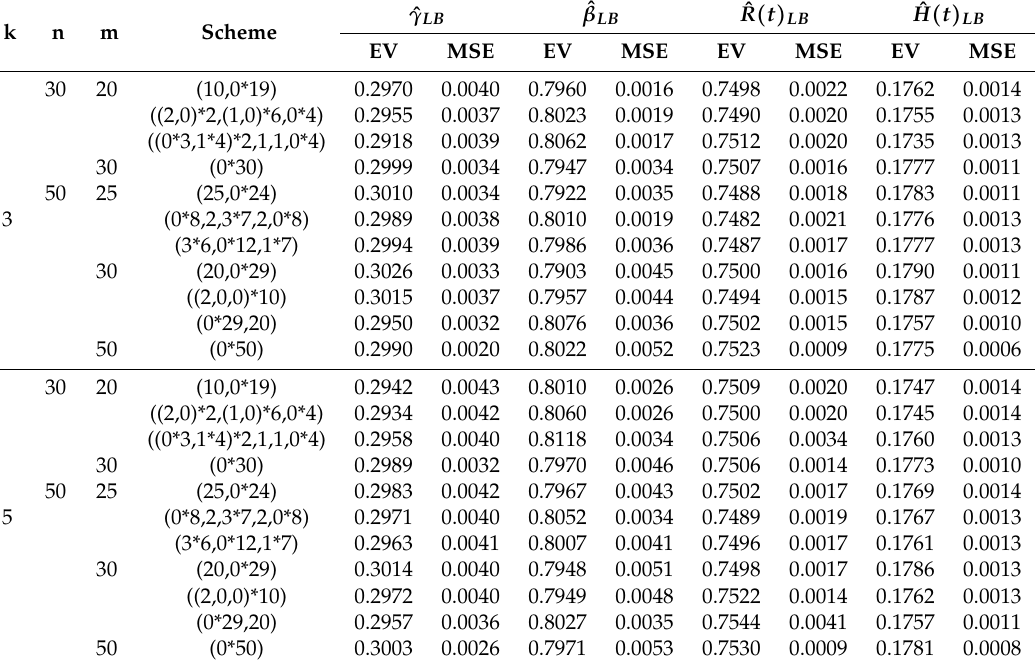
Table 10. Lindley approximation values and MSEs of parameters and reliability and hazard functions under GELF when q = 1, γ = 0.3, β = 0.8, t = 1.5, a 1 = 1.08, b 1 = 3.6, a 2 = 16, b 2 = 20, R ( t ) = 0.7563, H ( t ) = 0.1786, N = 1000.